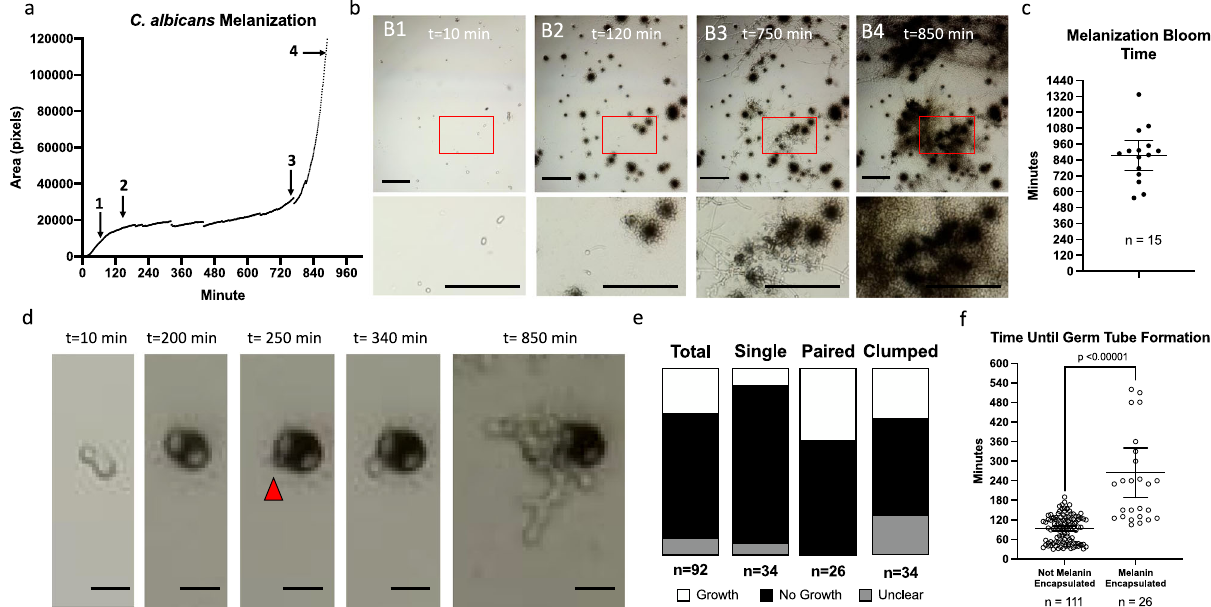
Fig. 5 Using time-lapse microscopy to gain insight into C. albicans yeast and hyphae interactions with the melanization immune response. a Kinetics of the melanization reaction within hemolymph incubated with C. albicans yeast, with a distinct tri-phastic response in which the yeast starts off non- encapsulated with melanin (1), followed by an initial peak of the melanization reaction (2), an extended plateau (3), and a greater second peak of the melanization reaction (4). b Using microscopy, we saw that the yeast start off non-melanized (B1), and most reached their peak melanin-encapsulation by 120 min (B2). After which, the yeast began to fi lament, and hyphae grew between 120 and 750 min with minimal melanin encapsulation occurring. At 750 min (B3), blastoconidium (yeast) began to form on the hyphae, which then corresponded to a rapid increase in melanization (B4). Scale bars in b indicate 100 µ m. c The time until this melanin bloom was ~14 h ( n = 15 biologically independent movies, mean = 874 min, 95% Con fi dence Interval 762 – 985 min). d Through these movies, we also saw that some melanin-encapsulated yeast were able to survive the immune response and grew from underneath the layer of pigment. The melanin-encapsulated C. albicans in panel d began to grow through the melanin by 250min. Scale bars in d indicate 10 µ m. e Overall, ~23% of melanin-encapsulated yeast were able to grow following melanin-encapsulation. Pairs of melanin-encapsulated yeast had the highest percentage of growth following melanin encapsulation, with a 33% frequency. f In the yeast that grew following melanin-encapsulation, the time until germ tube formation was delayed 265 min on average ( n = 26 independent melanin-encapsulated fungi), while in non-encapsulated yeast, the average time was 92 min ( n = 111 independent non-encapsulated fungi) (Two-tailed unpaired t -test, p < 0.00001, t = 8.878, df = 135) and error bars indicate mean with 95% Con fi dence Interval. a , b , d show representative data from three biological replicates. Each data point in c represents an independent biological replicate. e , f show data from 4 biological